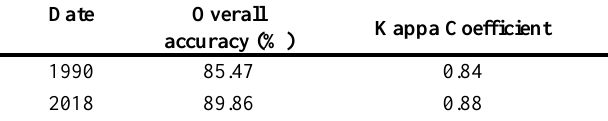
Table 4. Precision Statistical Parameters